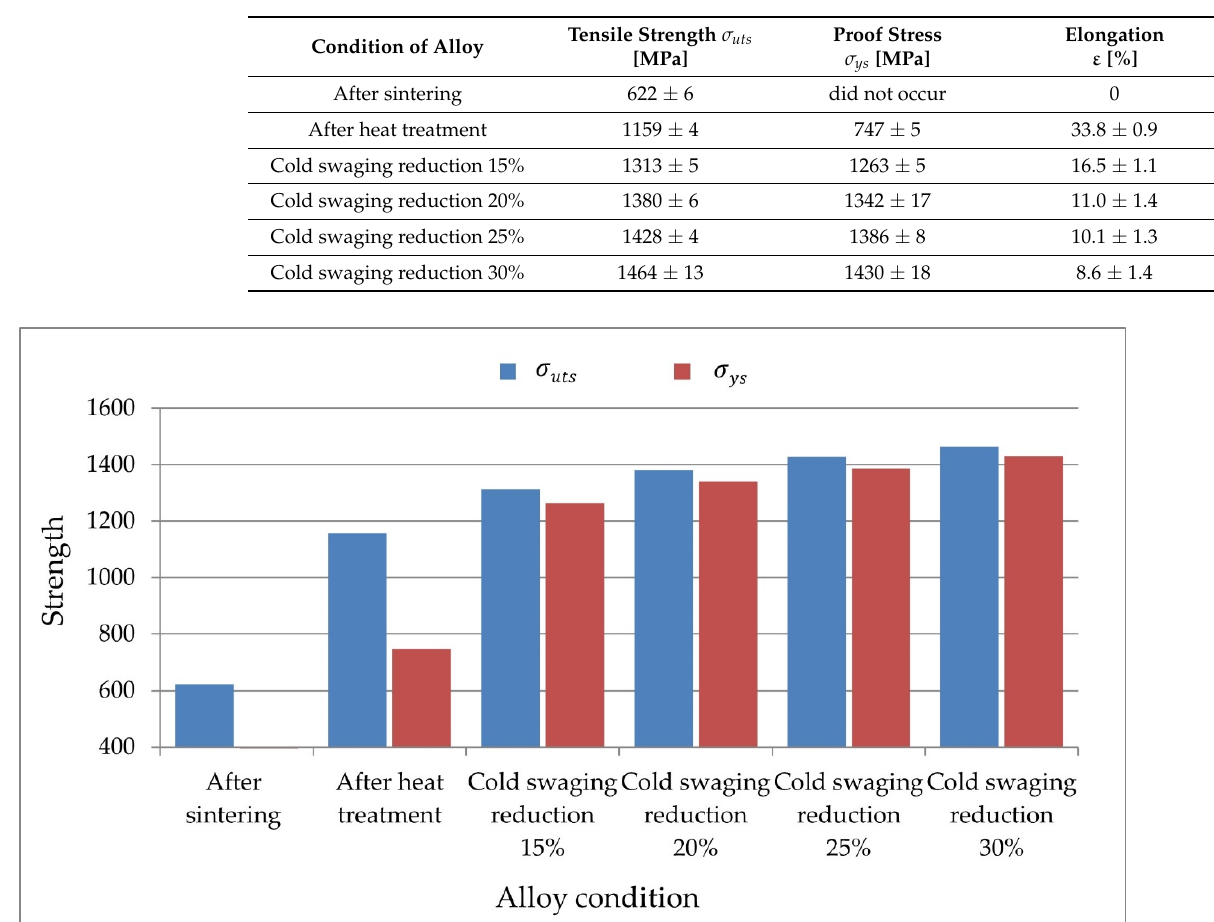
Figure 8. Elongation test results. 3.2. Analysis of the Microstructure Figure 9 contains metallographic [35] photographs showing the microstructure of 91WNi6Co3 alloy: after sintering (a), after heat treatment (b), and after cold swaging de- formation with reduction of 15% (c), 20% (d), 25% (e), and 30% (f). After heat treatment [36] in the matrix, during the observation of the microstructure, small separations are visible, invisible in the matrix after sintering. In the microstructure of the alloy, after cold swaging (Figure 9b), tungsten grains are visible, deformed plastically along the direction of swaging.